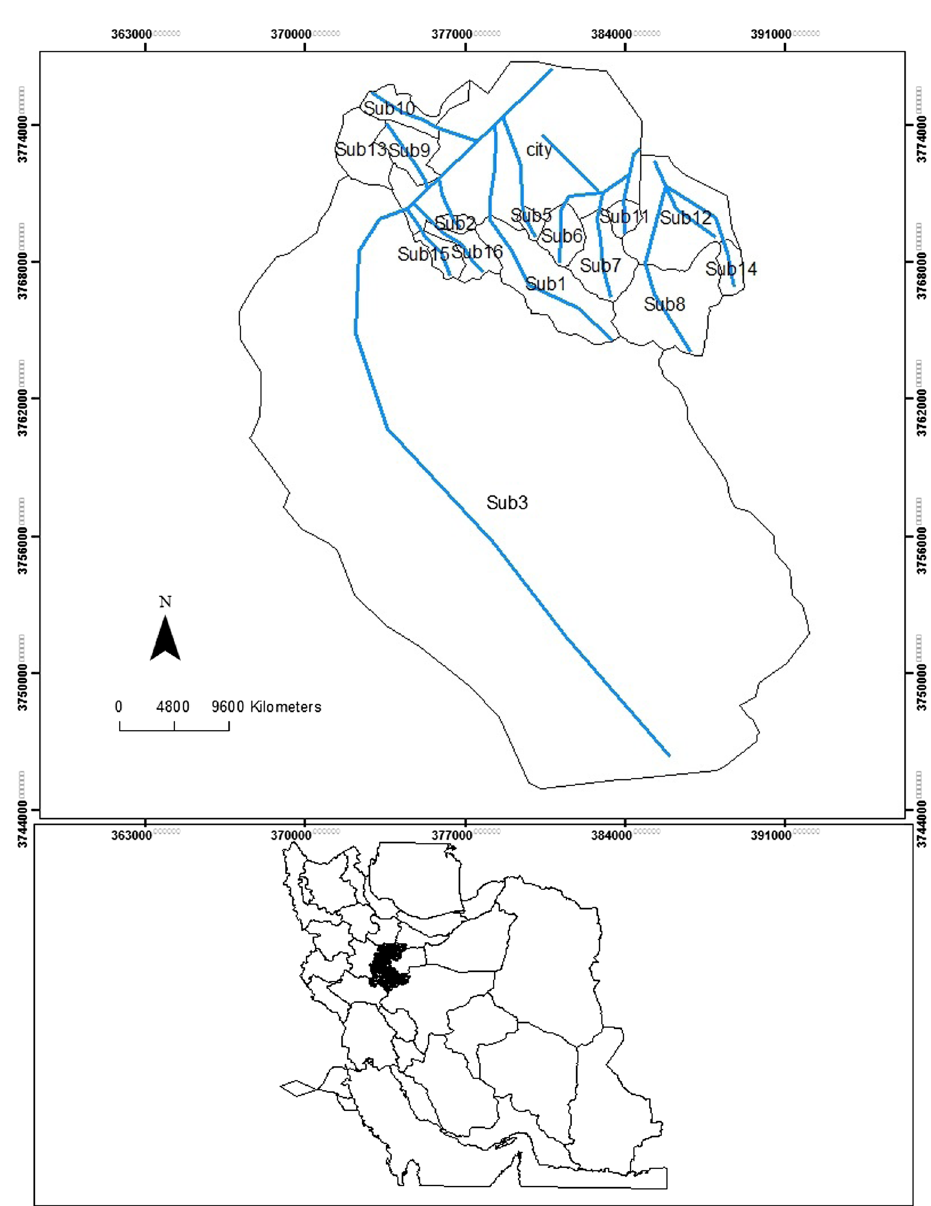
Fig. 1 The position